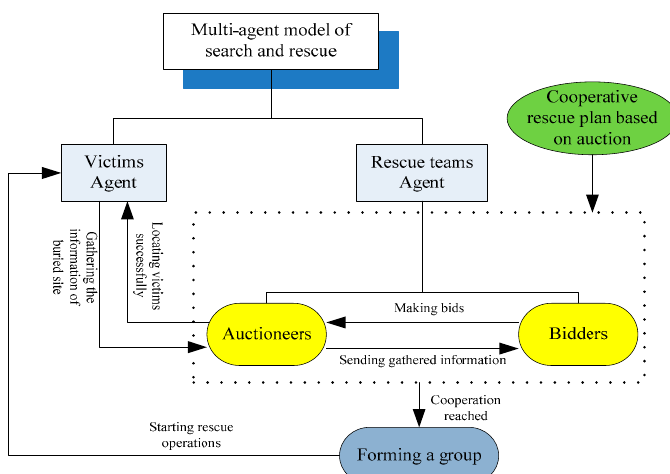
Figure 1. The model of multi-agent simulation.